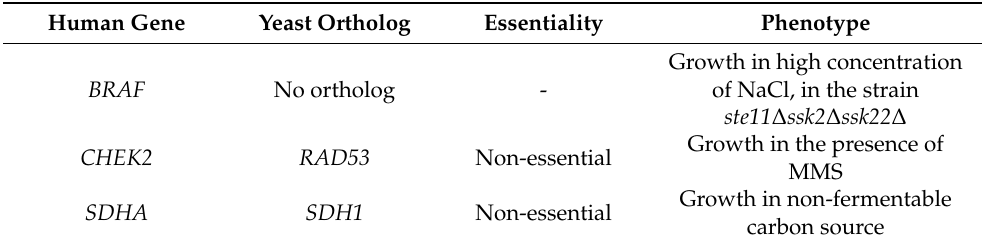
Table 4. Functional assays of genes listed in Table 2 and described in the